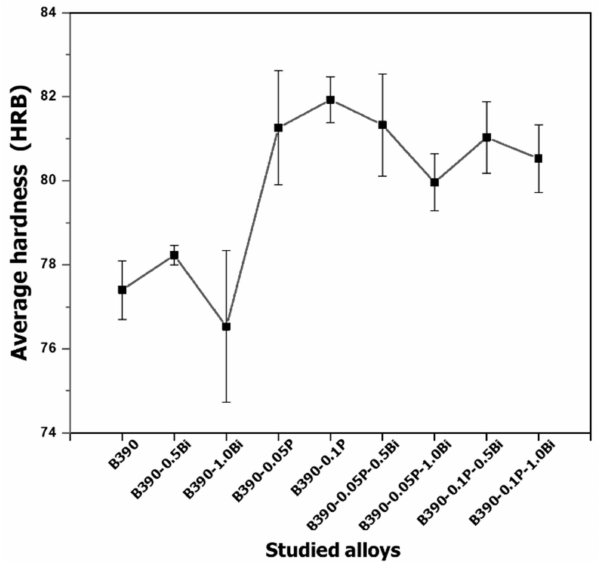
Figure 14. Average hardness of unmodified and modified as-cast